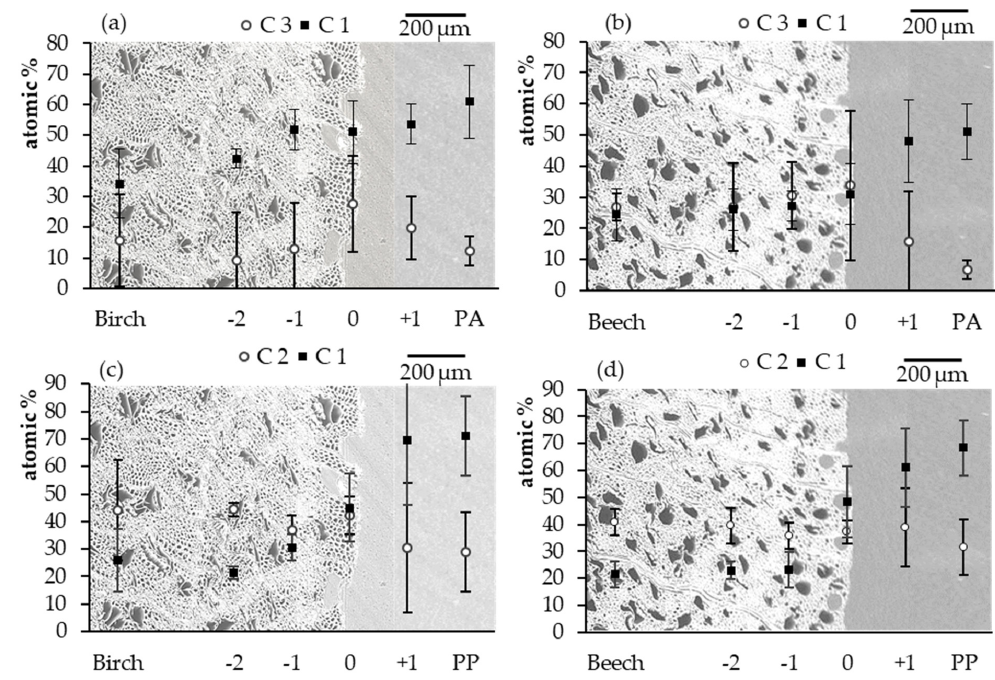
Figure 8. Mean values and standard deviation of the XPS results: Carbon peak components at C 1 and C 3 for birch solid wood ( a ) and beech solid wood ( b ) overmolded with PA 6 and the C 1 and C 2 for birch solid wood ( c ) and beech solid wood ( d ) overmolded with PP.